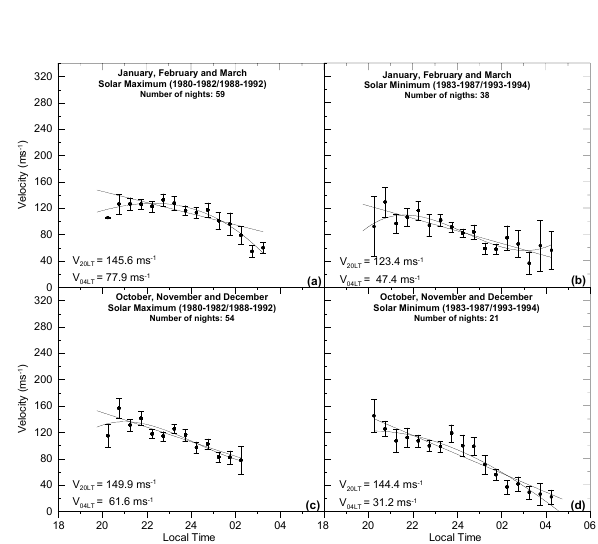
Figure 1. Zonal velocities of the plasma bubbles versus Local Time for (a) January/February/ March solar maximum, (b) January/ February/ March Fig. 1. Zonal velocities of the plasma bubbles versus Lo- solar minimum (c) October/ November/ December solar maximum and (d) October/November/ December solar minimum. cal Time for (a) January/February/March solar maximum, ber/November/December solar